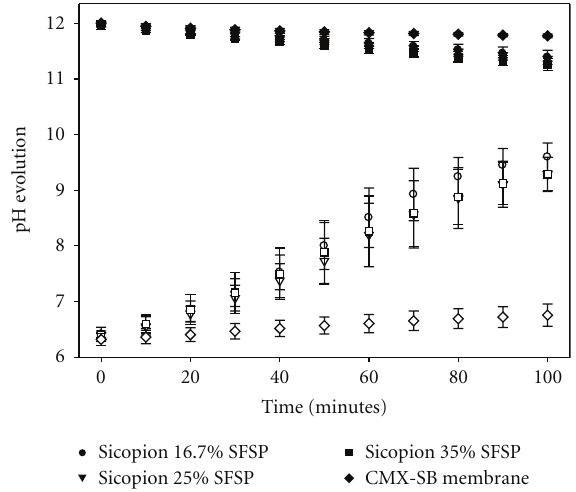
Figure 12: Conductivity evolution of the concentrate and diluate solutions (solid and empty symbols, resp.) during the 100-minute demineralization procedure. Membranes specified in the legend indicate the CEM defining the diluate